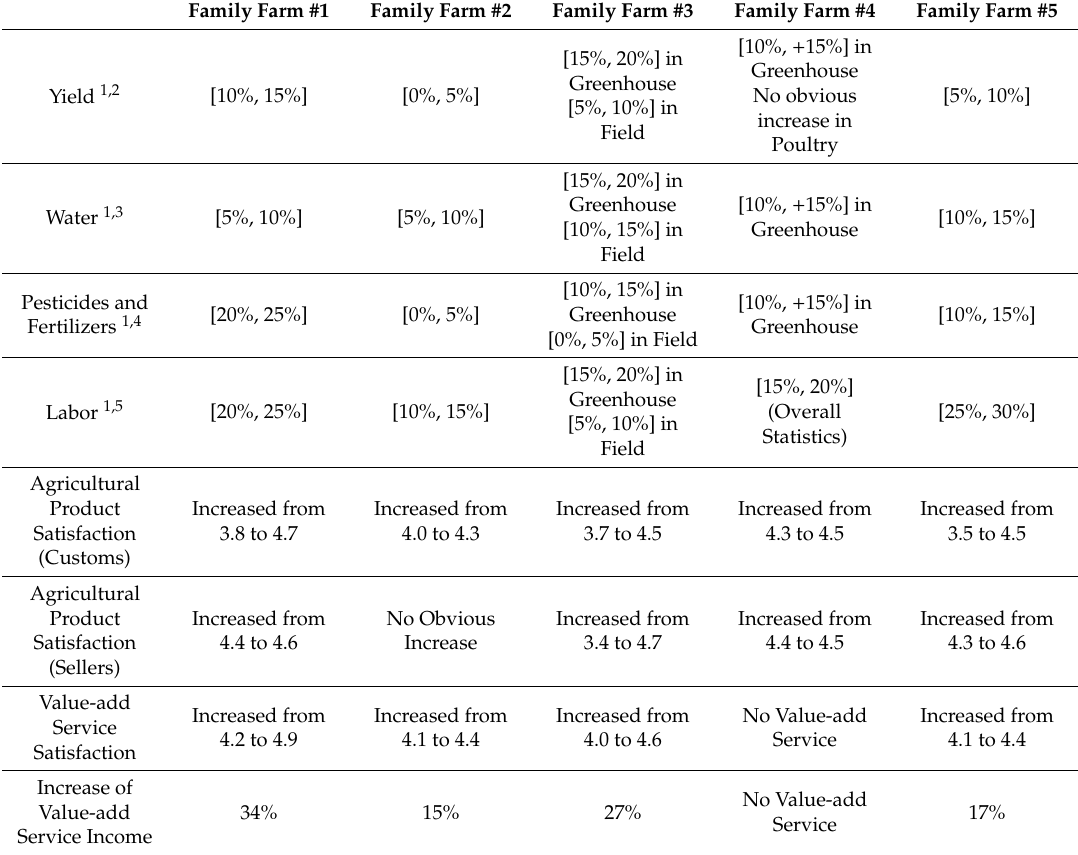
Table 3. System e ff ectiveness in in the family farms 1